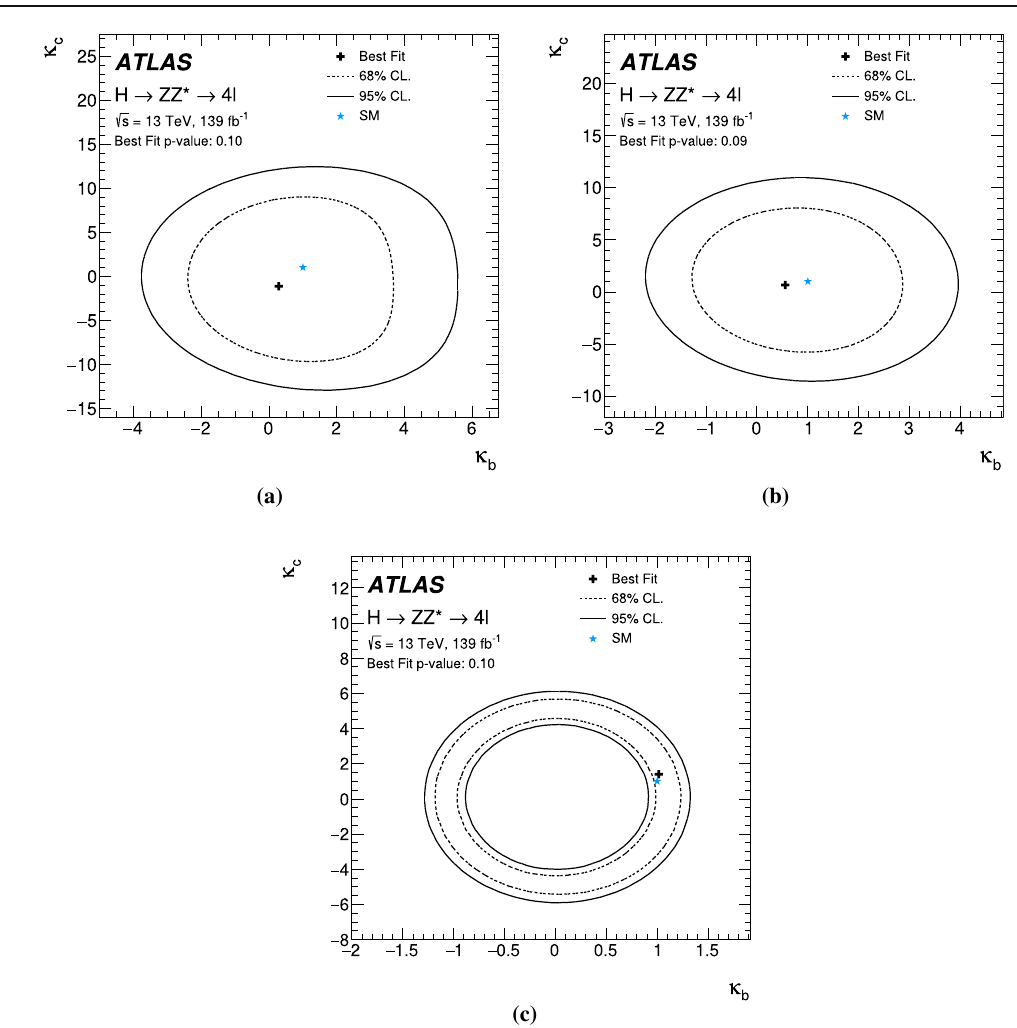
Fig. 41 Observed limitsat95% CLonYukawa couplings κ c and κ b for the three scenarios considered: a only the p 4 (cid:3) shape is used to constrain T κ κ 4 (cid:3) differential cross section is used; c both c and b ; b the predicted p T the prediction of the p 4 (cid:3) differential cross section and the modification T